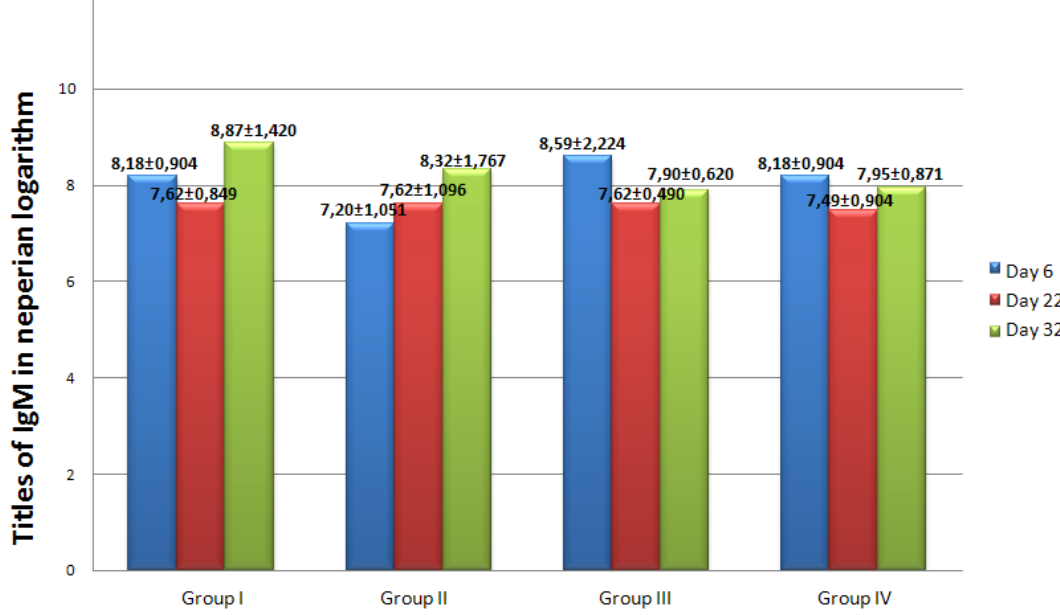
FIGURE 2 - Titles of total M Immunoglobulins in different groups P.S.: Variance’s Analysis by ANOVA, one way: Group 1, 2, 3 e 4: p=0,5993